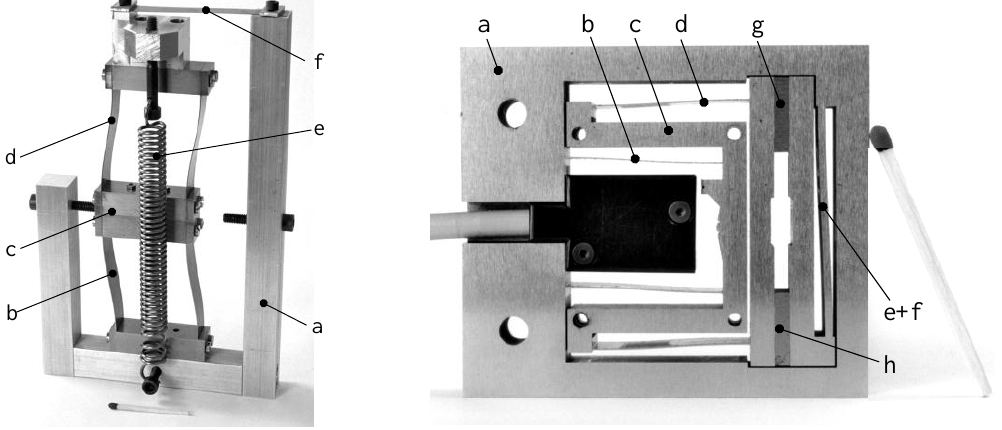
Figure 1. Parallel spring stage equipped with a stiffness compensation mechanism. Left: mock-up model showing the architecture. Right: same arrangement machined monolithically by wire-electrodischarge machining (wire-EDM). (Fig. 1). In this arrangement, the middle-point of the blade (e + f) is placed on the axis of symmetry of the mechanism.